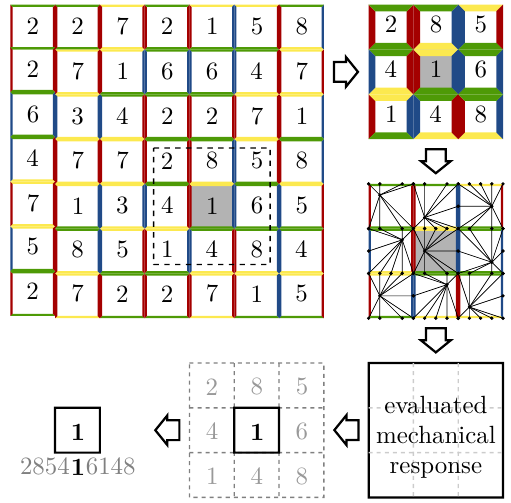
Figure 9. Local tiling process: macro tiling ⇒ local tiling ⇒ local FE mesh ⇒ evaluation ⇒ cropping results ⇒ results for tile T . i